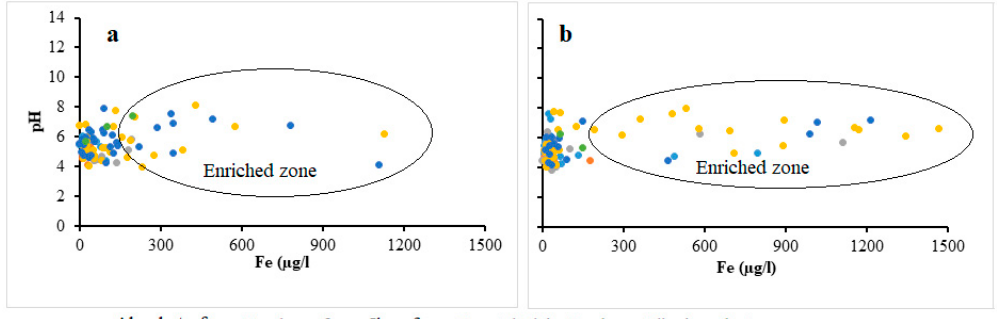
Figure 6. Scatter plots of Fe against pH for ( a ) wet and ( b ) dry season.